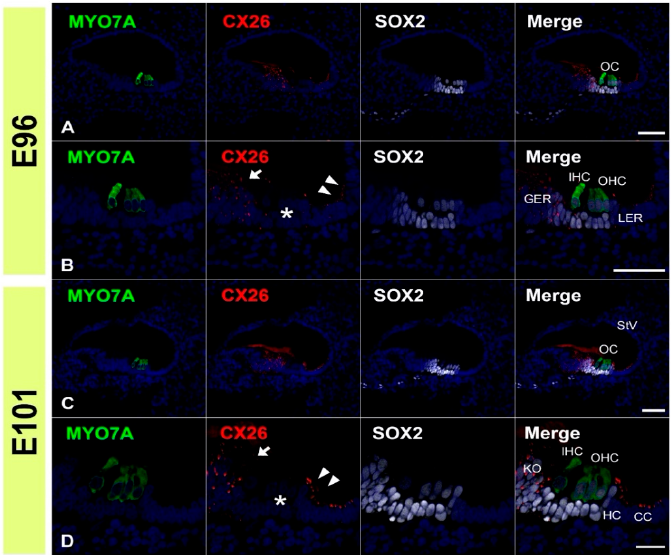
Figure 1. Changes in the expression patterns of CX26 at E96 and E101. ( A , B ) At E96, CX26 was expressed in the prosensory domain. While CX26 expression was observed in portions of the modiolus (arrow in ( B )) and lateral (arrowhead in ( B )) sides of the sensory epithelium, no expression was observed around the MYO7A-positive outer hair cells (asterisk in ( B )). ( C , D ) At E101, CX26 expression was observed in Kölliker’s organ (arrow in ( D )), immature Hensen’s cells (arrowhead in ( D )), Claudius’ cells, and outer sulcus cells. No expression was observed in the organ of Corti (asterisk in ( D )). SOX2 was used to label supporting cells. Nuclei were counterstained with Hoechst stain (blue). Scale bar: 50 µ m in ( A – C ), 20 µ m in ( D ). OC: organ of Corti, IHC, inner hair cells; OHC, outer hair cells, GER: greater epithelial ridge, LER: lesser epithelial ridge, StV: stria vascularis, KO: Kölliker’s organ, HC: Hensen’s cells, CC: Claudius’ cells, ( A – D ): basal